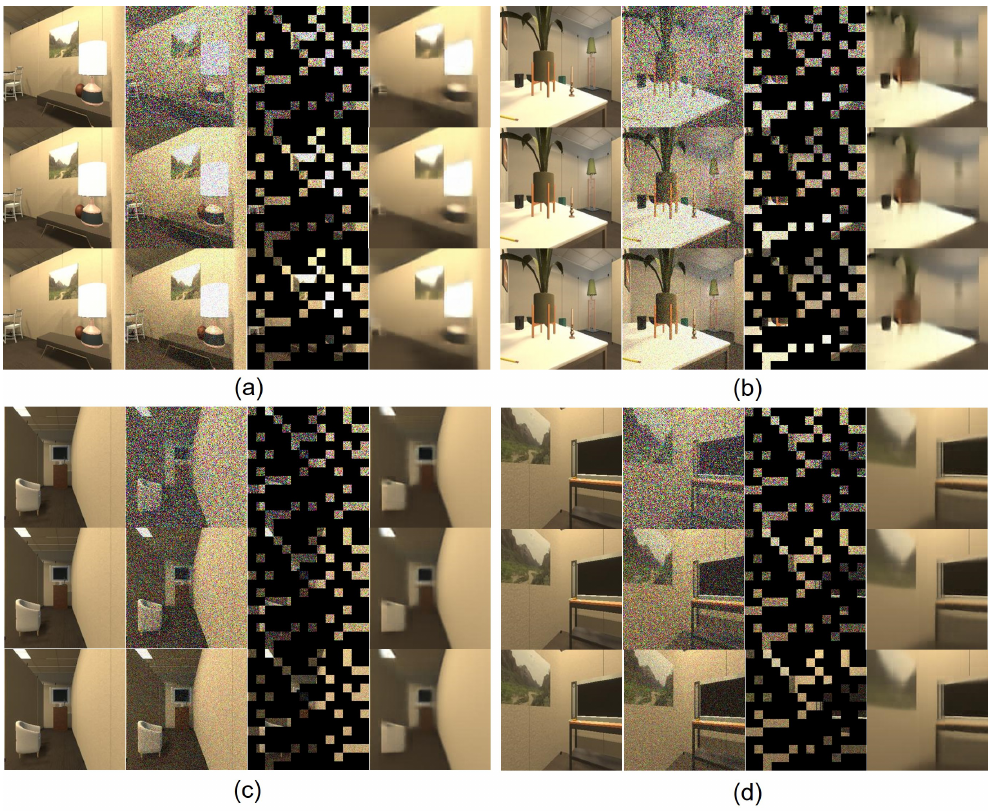
Figure 8. RDMAE reconstruction visualization. ( a – d ) are from four different scenes in the RoboTHOR validation set. For each image from left to right are: the original image, the Gaussian noise image (from top to bottom noise level σ = 0.5, 0.25, 0.1), the masked Gaussian noise image, and the reconstructed